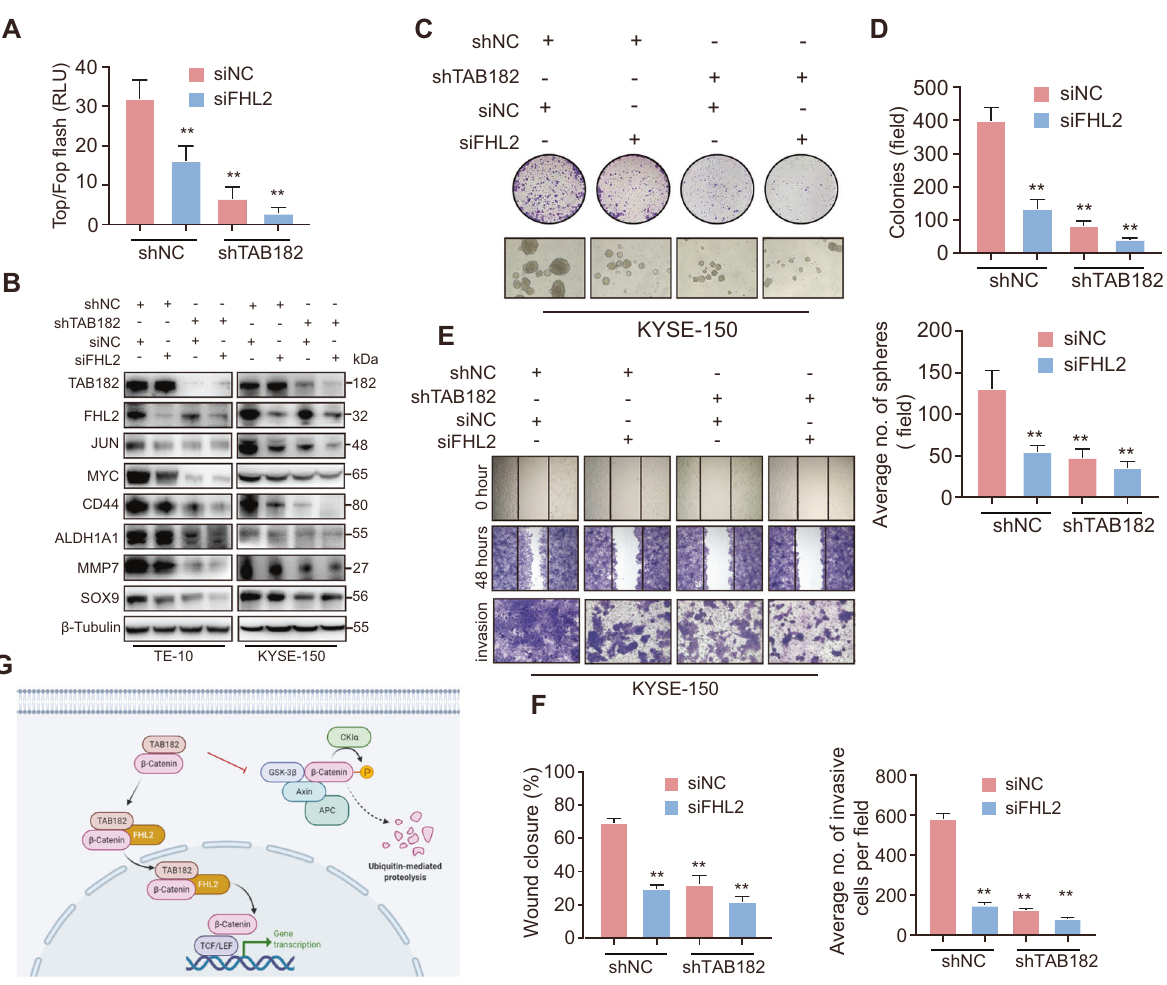
Fig. 7 TAB182 is a novel regulator of the FHL2- β -catenin axis. A TOP/FOP luciferase assay was used to examine the β -catenin activation in KYSE-150 cells. B protein expression of the β -catenin target genes was determined by western blot. C , D cell clonogenic ability and clonal sphere formation ability of TAB182- Δ 1 and TAB182-WT cells was evaluated. E , F migratory and invasive capabilities of TAB182- Δ 1 and TAB182- WT cells were evaluated using transwell and wound healing assays. G schematic depiction of the mechanisms how TAB182 act as a novel activator of the FHL2- β -catenin axis in ESCC